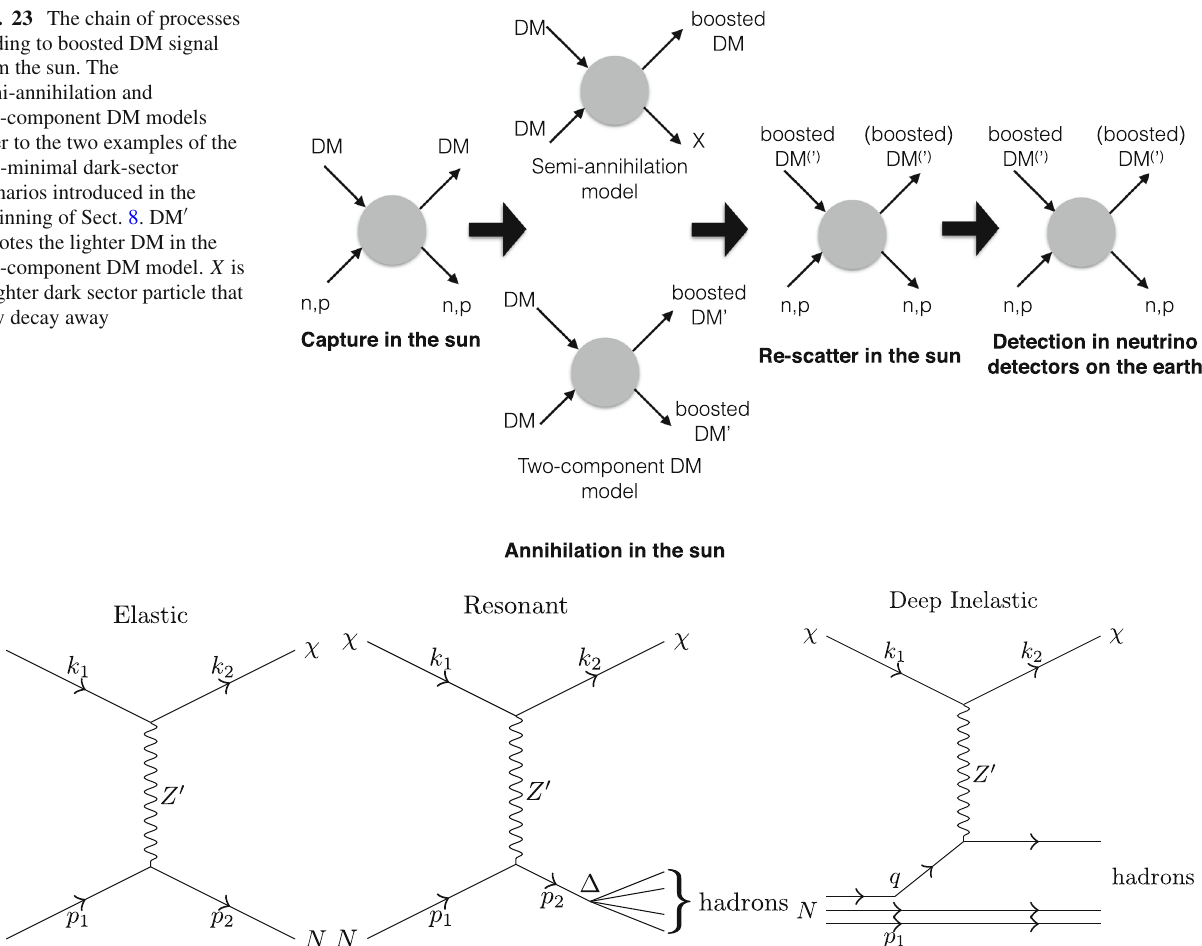
Fig. 24 Diagram illustrating each of the three processes contributing to dark matter scattering in argon: elastic (left), baryon resonance (middle), and deep inelastic